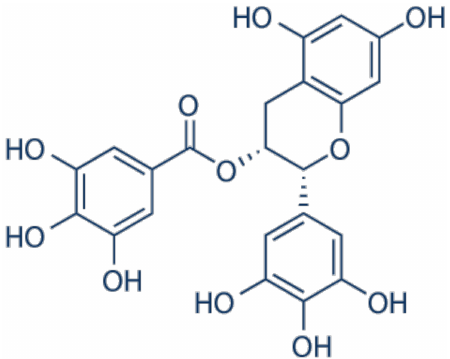
Figure 10. The chemical structure of epigallocatechin-3-gallate.